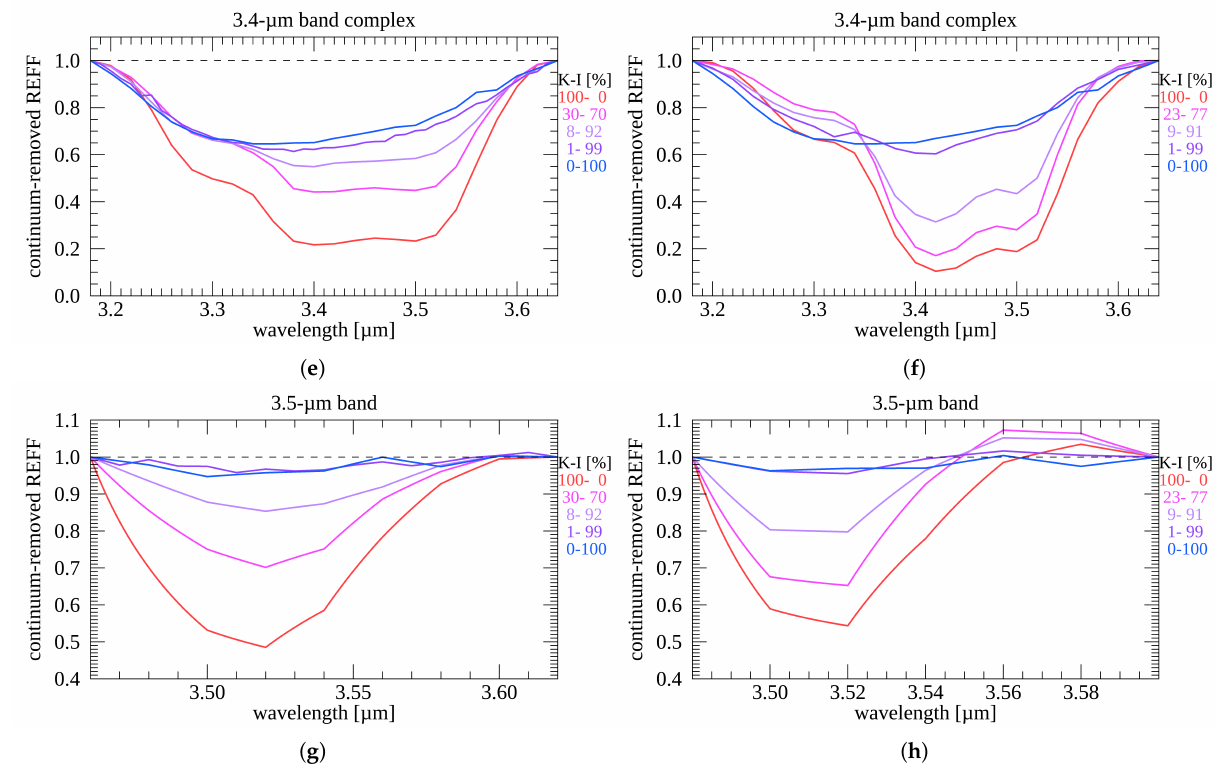
Figure 5. Kerite-related absorption features for water ice–kerite 45–63 ( left panels: a , c , e , g ) and water ice–kerite < 25 ( right panels: b , d , f , h ) intimate mixtures. The name of the monitored feature is indicated in the corresponding panel title. Absorption bands are plotted after continuum-removal and the black dashed line in each plot indicates the continuum- removed baseline. Kerite (K) and water ice (I) mass fractions are